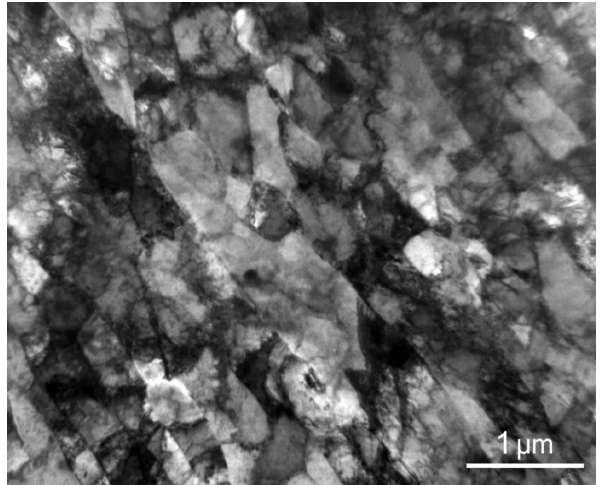
Figure 19: Dislocation structure after constant stress amplitude loading,  = 340 a